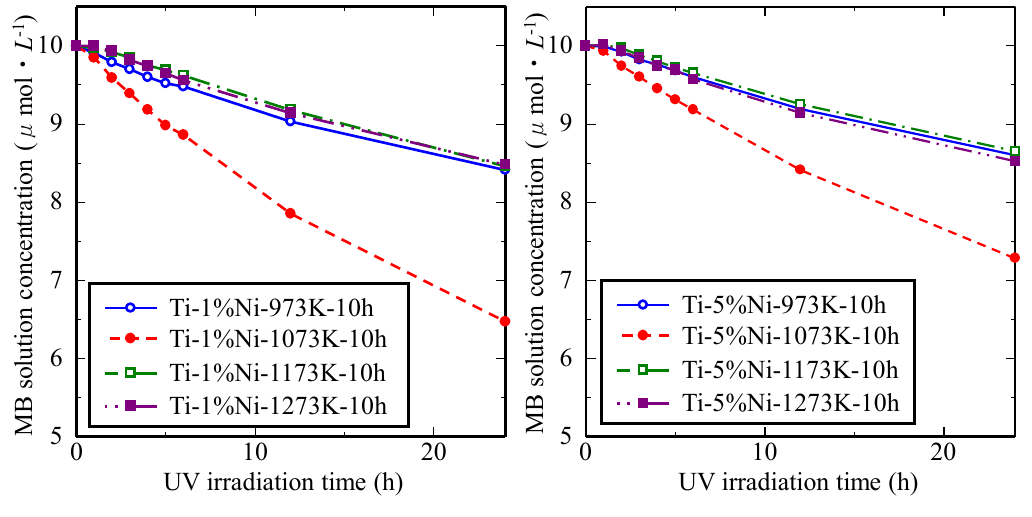
Figure 47. MB degradation under UV of M10- x Ni- y K